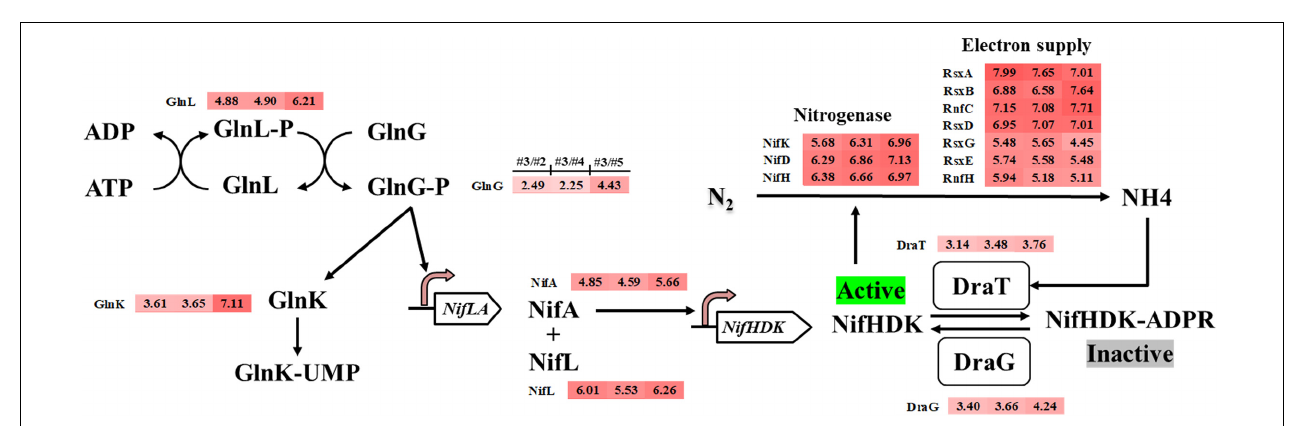
FIGURE 2 | Identification of differentially expressed genes (DEGs) under different gas supply conditions (0.28/#1, 0.58/#2, 0.93/#3, 1.31/#4, 5.24/#5). (A) Hierarchical clustering was performed using the LSmean of DEGs, in which significant gene rows were included by comparing any two conditions with at least one p -value < 0.01. X -axis represented different gas supply conditions and Y -axis represented DEGs. (B) Venn analysis of DEGs under gas supply ratio of 0.93 (#3) compared with other three conditions of #2, #4, and #5, respectively.